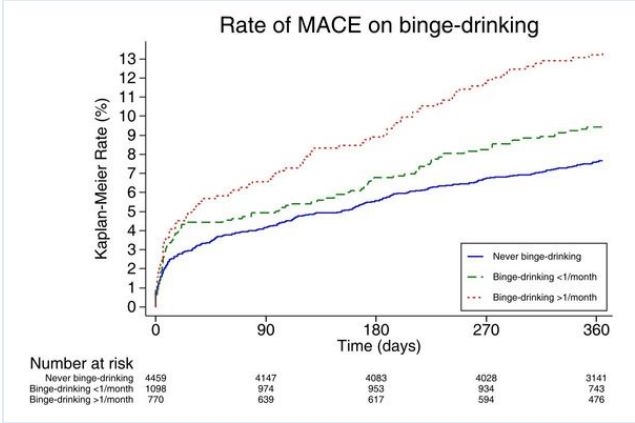
FIGURE 1: Kaplan-Meier rates of incident MACE (cardiac death, MI, stroke or clinically indicated target revascularization) after ACS by frequency